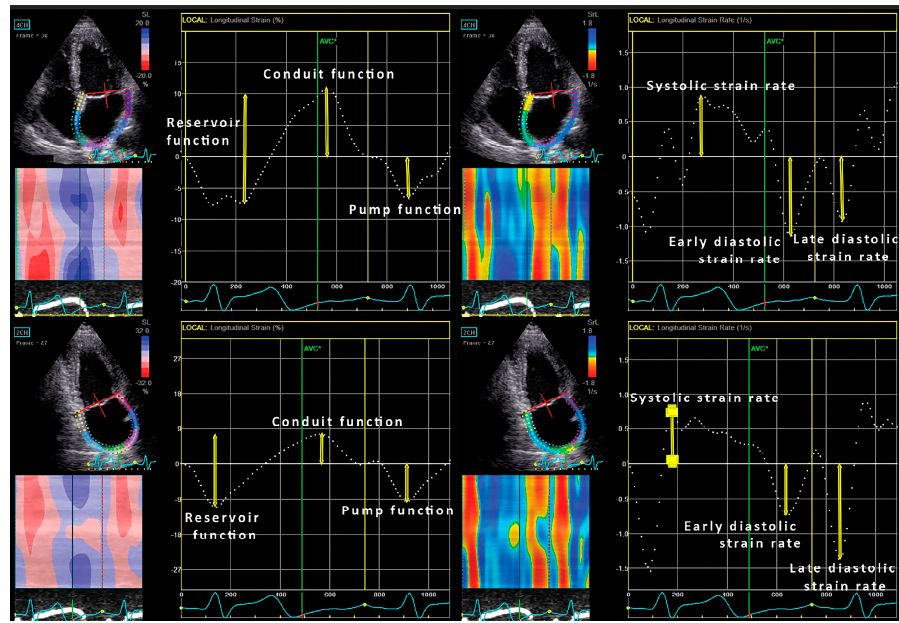
Figure 1. Left atrial strain and strain rate analysis in the four-chamber view (upper two plots, consequently) and in the two-chamber view (lower two plots, consequently).